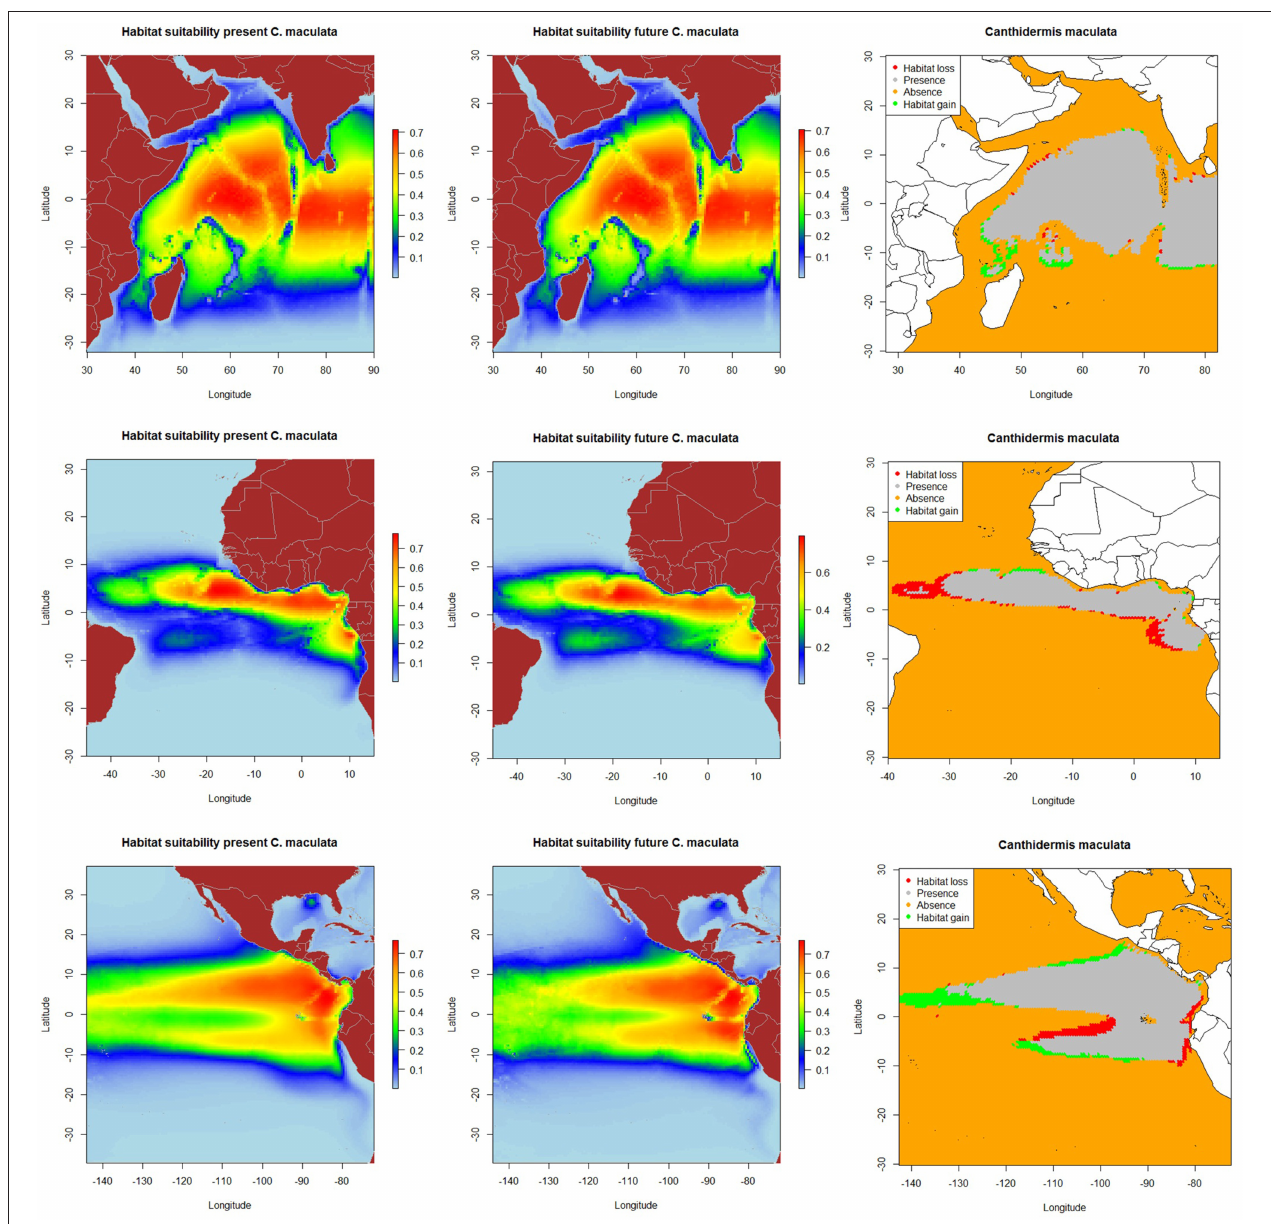
FIGURE 2 | Predicted current conditions (first column), future conditions (second column), and differences between future and present conditions (third column) for habitat suitability areas for Canthidermis maculata in the Indian, Atlantic, and Eastern Pacific Ocean. The maps (first and second columns) show the probability of occurrence of each species from lowest (blue) to highest value